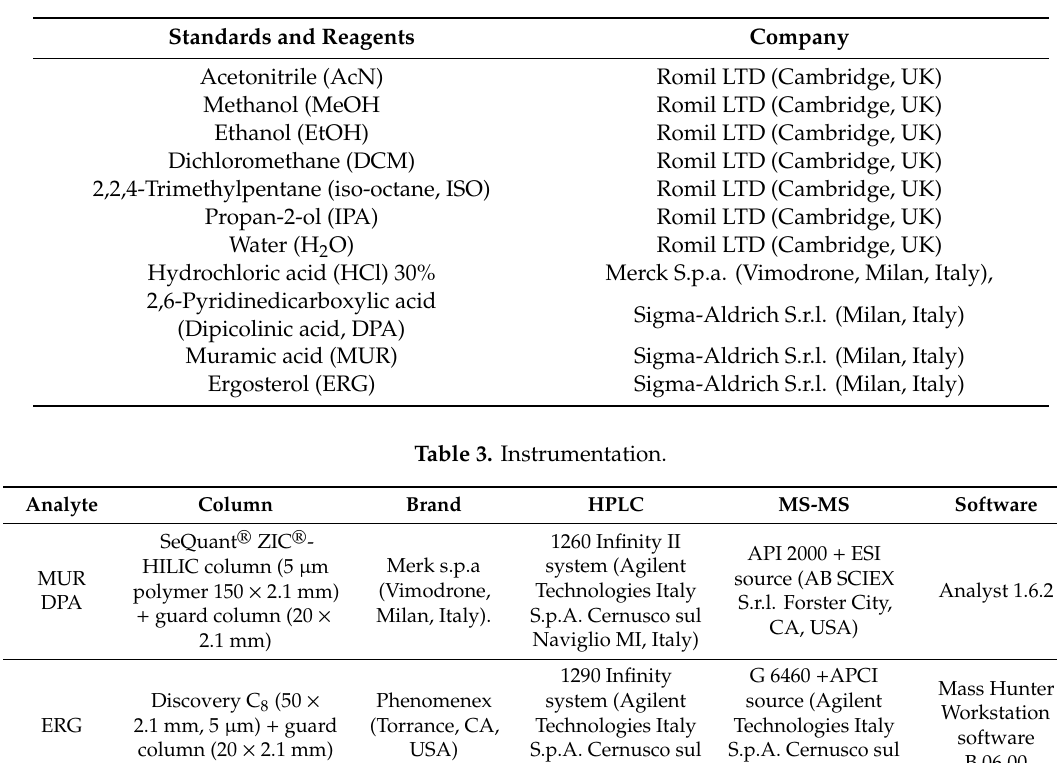
Table 2. Standard and reagent brands.